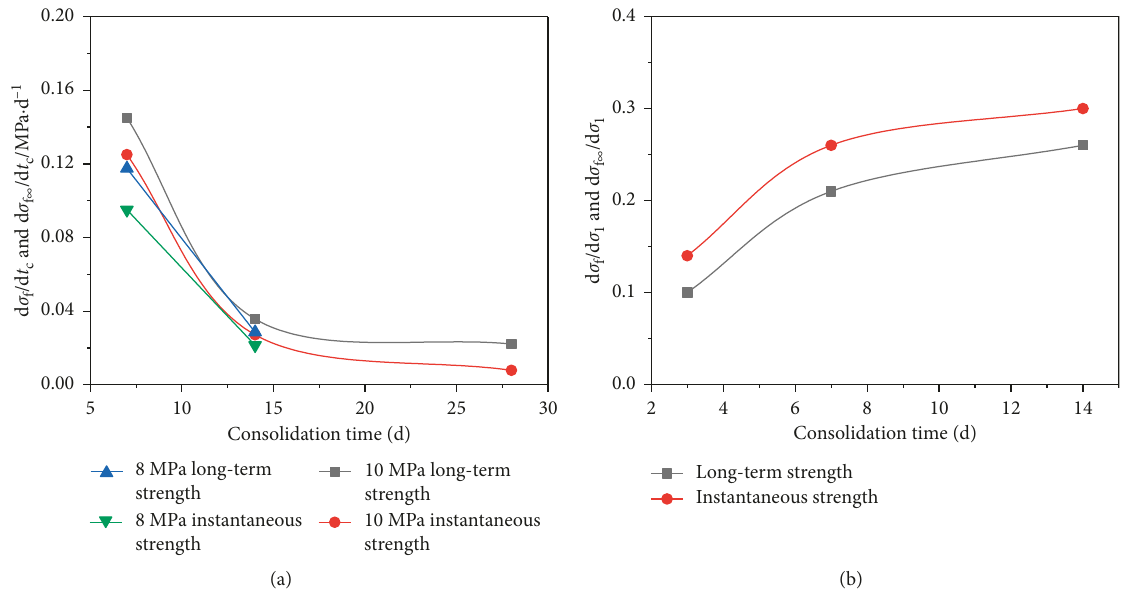
Figure 8: Variations in the rates of increase in the instantaneous and long-term strengths of the frozen clay: (a) d σ (b) d σ f /d t c and σ f ∞ /d t c vs. t c .